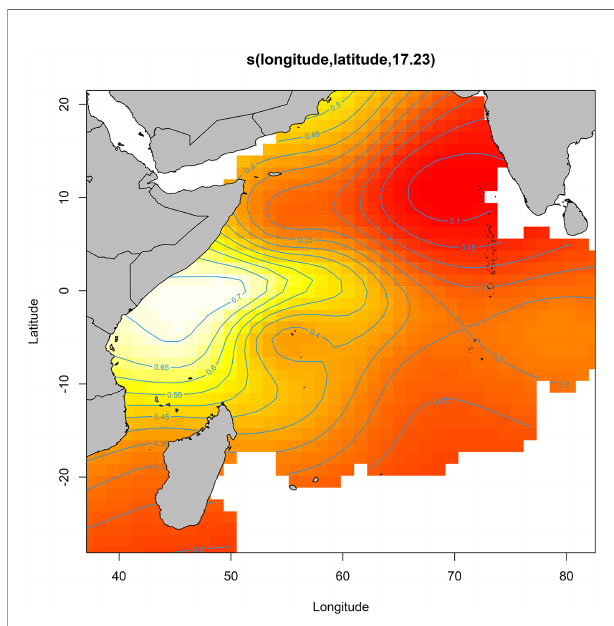
FIGURE 3 | Partial effect of the interaction between latitude and longitude in the fi nal model for predicting the catch probability of an oceanic whitetip shark. Isoclines indicate the catch